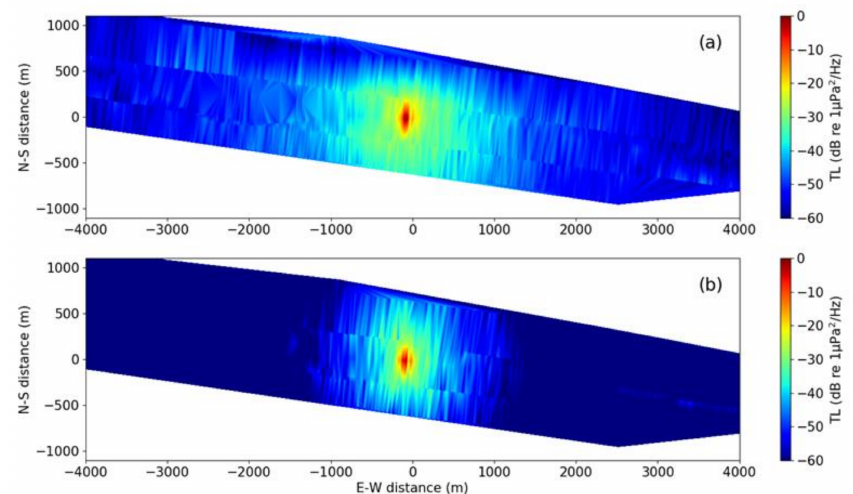
Figure 4. Spatial transmission loss for the two sonar systems on the CCGS Vector. Received sound pressure levels (SPL) relative to maximum SPL for the ( a ) 12 kHz and ( b ) 50 kHz sonars are shown.